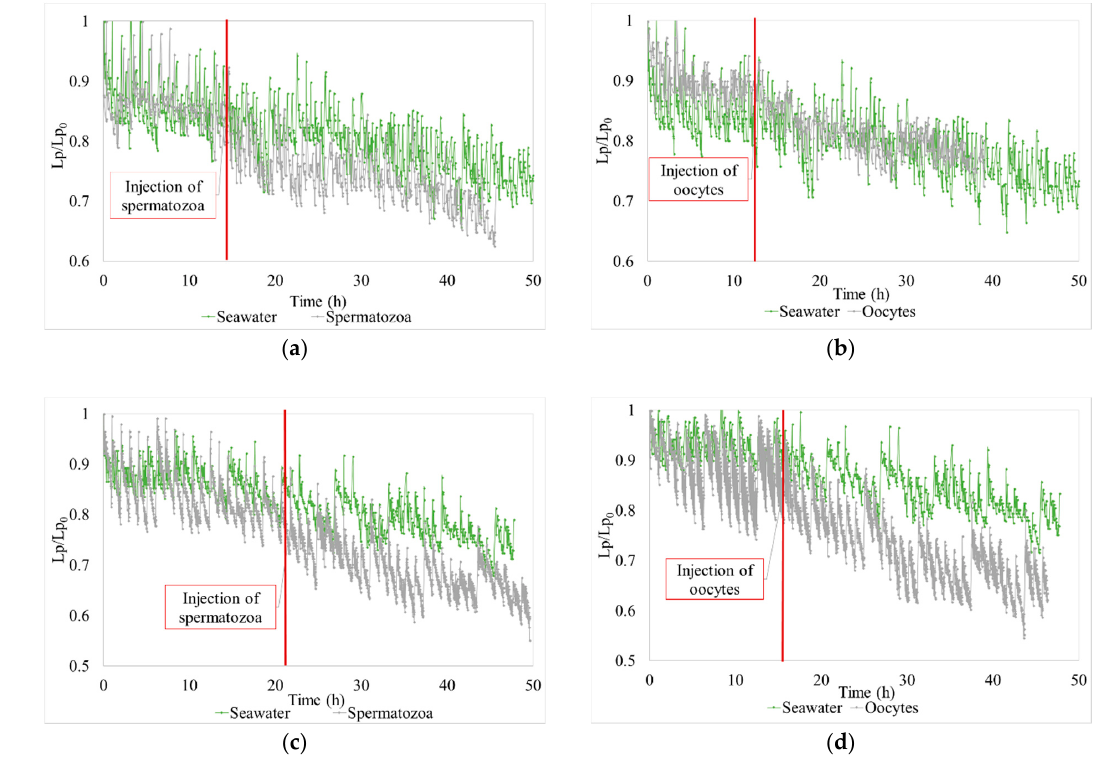
Figure 7. Variation of permeability vs. time during the 30 h filtration of gametes (chronic pollution). ( a ) Spermatozoa—[J = 60 L h − 1 m − 2 and t filtration = 30 min]; ( b ) Oocytes—[J = 60 L h − 1 m − 2 and t filtration = 30 min]; ( c ) Spermatozoa—[J = 60 L h − 1 m − 2 and t filtration = 60 min]; ( d ) Oocytes—[J = 60 L h − 1 m − 2 and t filtration = 60 min].